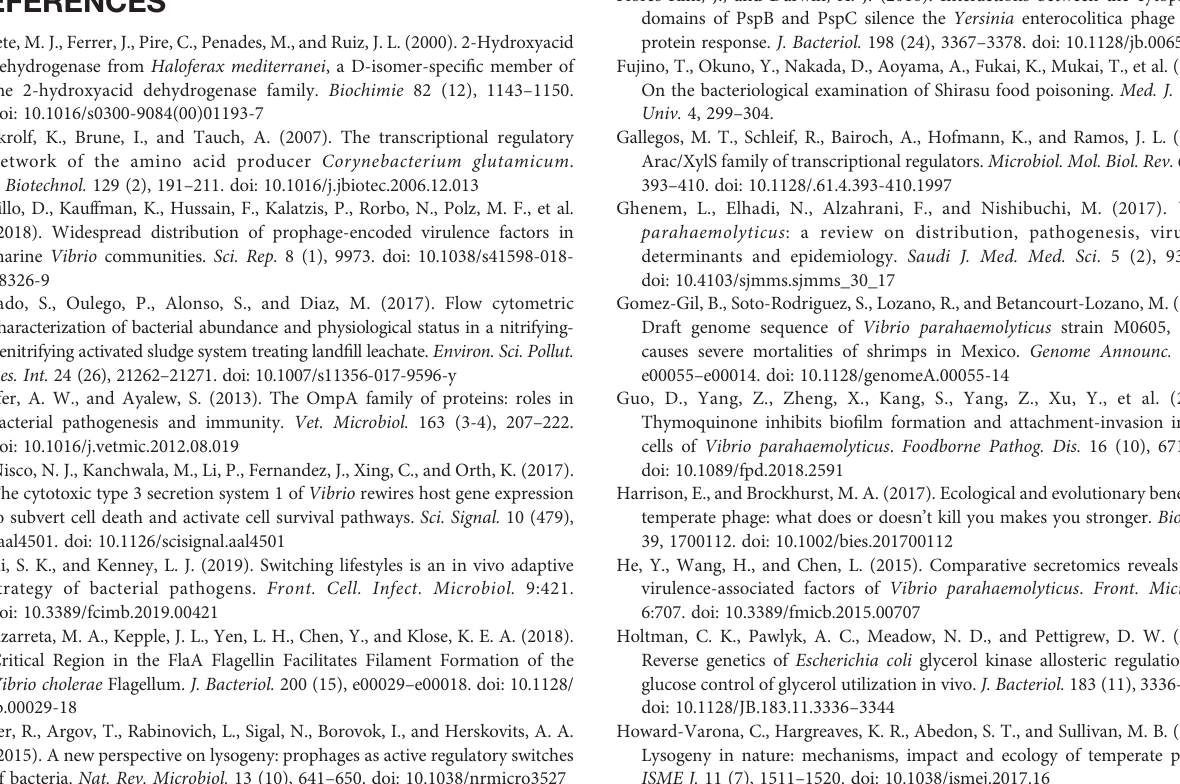
SUPPLEMENTARY FIGURE 1 | Construction ofthe D VpaChn25_0724 , and D VpaChn25_0724-com mutants by agarose gel electrophoresis analysis. (A) amplicons of upstream (Lane 1) anddownstream (Lane 2) sequences of the VpaChn25_0724 gene. (B) ampliconsfranking the upstream and downstream sequence of VpaChn25_0724 . (C) amplicons of the upstream anddownstream sequence of VpaChn25_0724 in the recombinant pDS132+ VpaChn25_0724 plasmids. Lines 1 – 6, positive recombinant plasmids; Line 7, blankcontrol; Line 8, positive control. (D) amplicons of transformants with the VpaChn25_0724 -up-F and